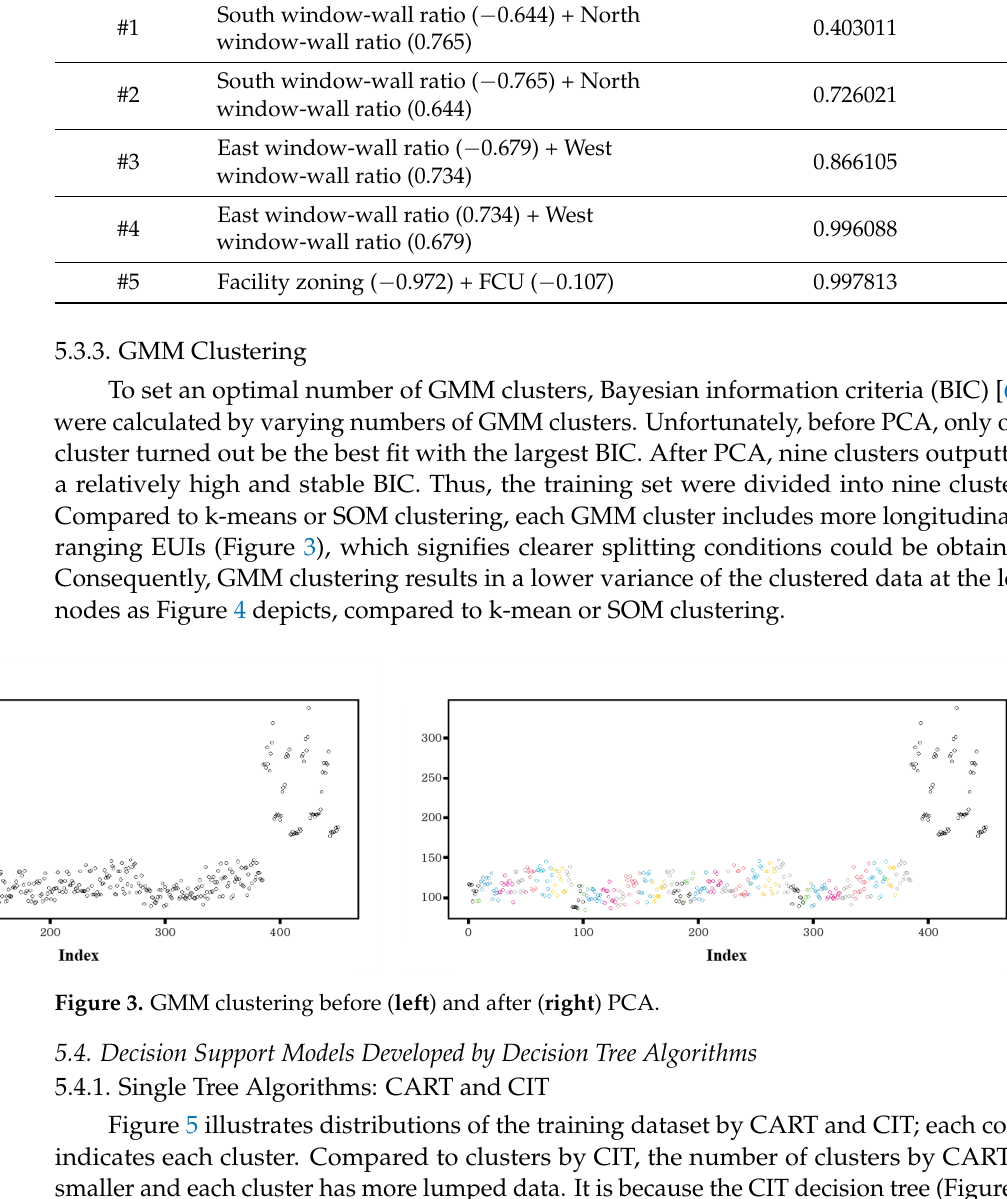
Table 6. Composite variables selected after dimension reduction by PCA.